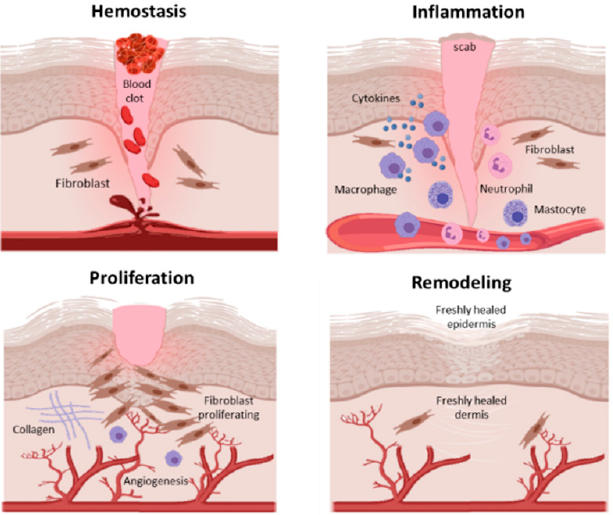
Figure 1. Phases of the wound healing process: hemostasis; inflammation; proliferation; remodeling.